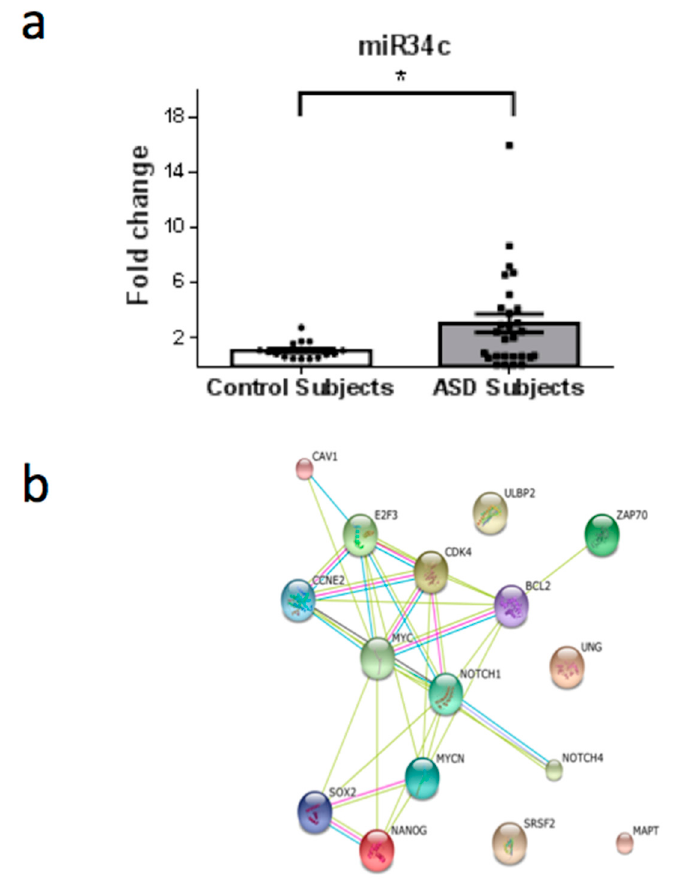
Figure 1. ( a ) Scatter plot of differential relative expression of miR34c in peripheral blood of ASD subjects compared to control subjects. Results expressed as mean ± standard error. t -Test analysis; * p < 0.05. ( b ) mRNA validates targets for miR34c selected in miRBase and respective proteins clusters that can be involved in ASD. Proteins involved in epigenetic regulation: NANOG (Nanog homeobox); NOTCH1 (notch 1); SOX2 (SRY (sex determining region Y)-box 2); SRSF2 (serine/arginine-rich splicing factor 2); NOTCH4 (notch 4); E2F3 (E2F transcription factor); MYCN (v-myc myelocytomatosis viral related oncogene, neuroblastoma derived); MYC (v-myc myelocytomatosis viral oncogene homolog). Proteins involved in cell cycle: CCNE2 (cyclin E2); BCL2 (B-cell CLL/lymphoma 2). Proteins involved in immunological regulation: ZAP70 (zeta-chain (TCR) associated protein kinase 70kDa); ULBP2 (UL16 binding protein 2); CDK4 (cyclin-dependent kinase 4); CAV1 (caveolin 1). Protein associated with cytoskeleton stabilization in neuronal cell: MAPT (microtubule-associated protein tau (776 aa)). Protein involved in DNA repair: UNG (uracil-DNA